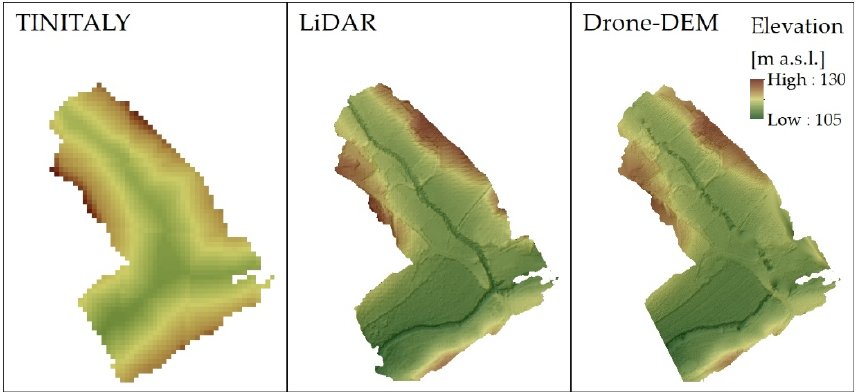
Figure 4. TINITALY, LiDAR, and Drone-DEM elevations models for the study area.